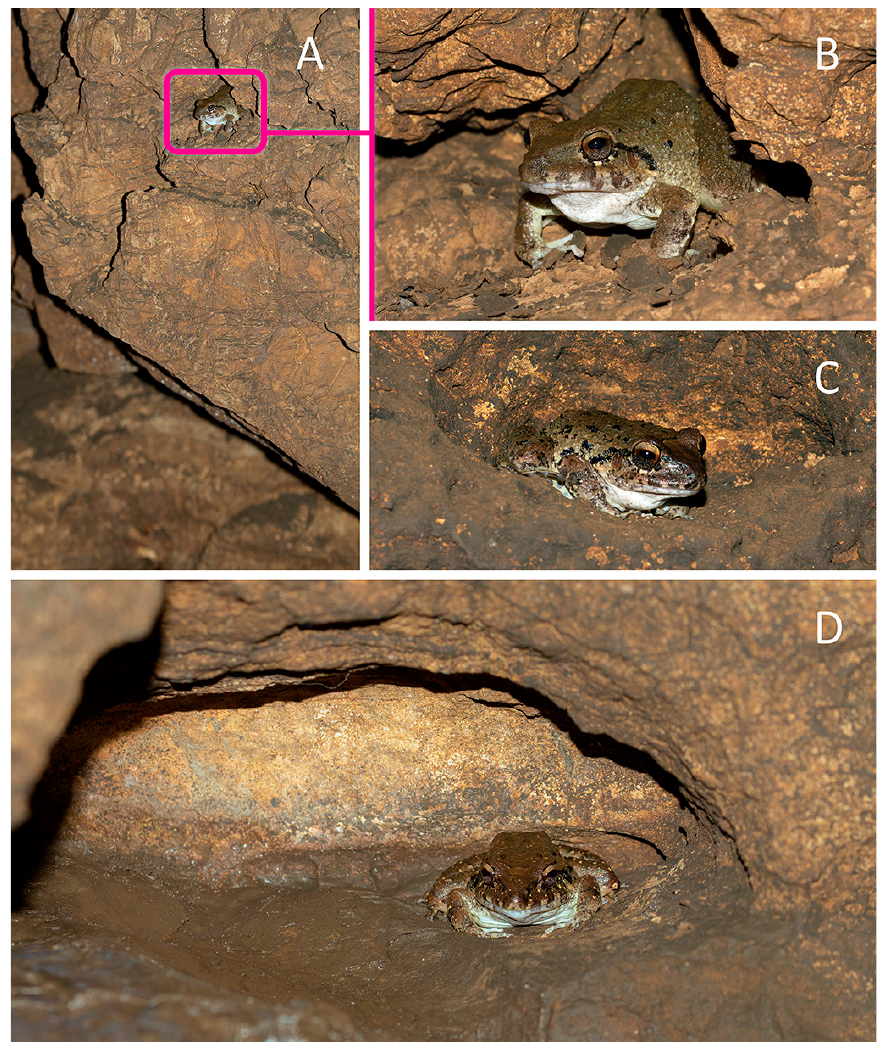
Figure 2. Adult individuals of Craugastor pelorus found inhabiting El Encanto cave (REBISCO, Tuxtla Gutiérrez, Chiapas, Mexico). ( A , B ). Male hiding in a cavity on the rock wall at about 2 m above the ground (CNAR-RF 764a and 764e). ( C ). Individual resting on a pocket on the wall (CNAR-RF 766e). ( D ). Individual resting in a cavity on the rock wall (CNAR-RF 767d). Photos by Gonçalo M. Rosa.